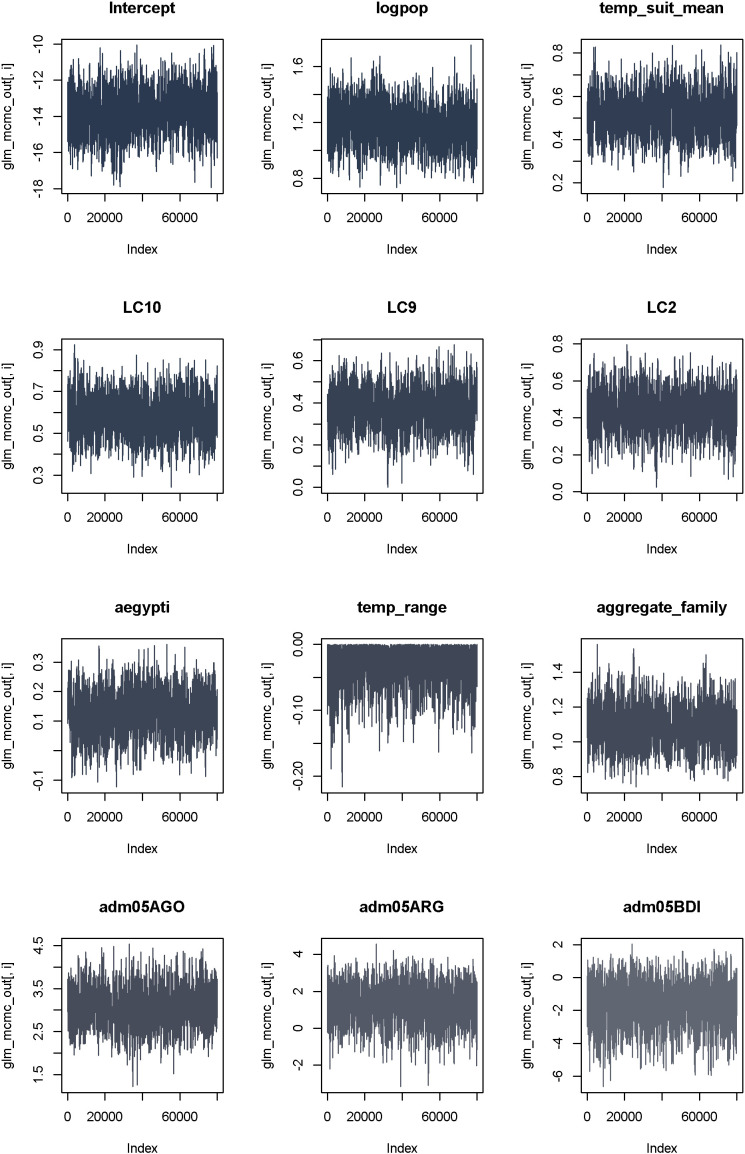
Trace plots from estimation of model variant 17 as an example of convergence.